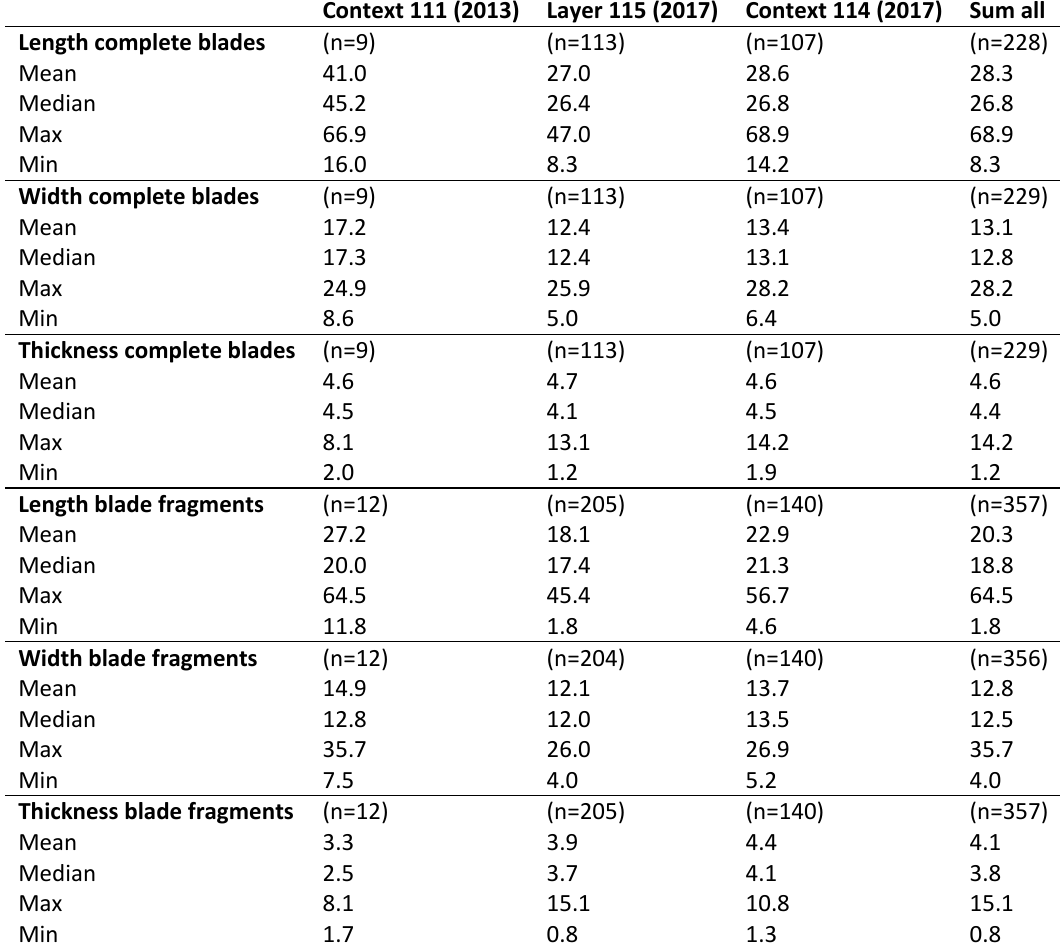
Table 3. Size distribution of blades. All measurements are maximum size. Numbers are blade sizes in